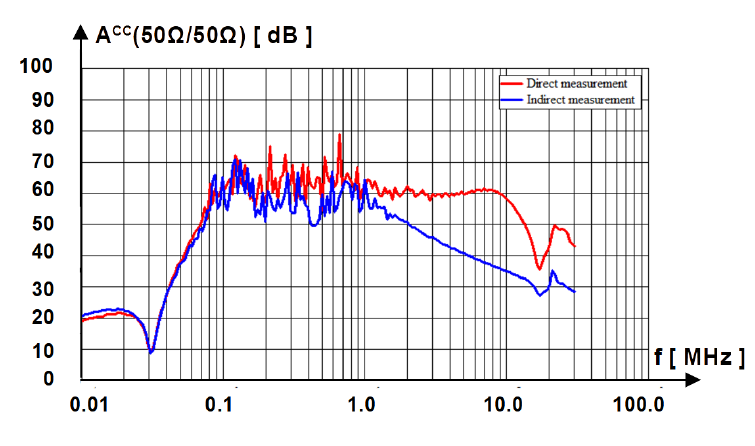
Figure 9. The test setup for the direct measurement of the common-mode attenuation of the exem- plary filter.